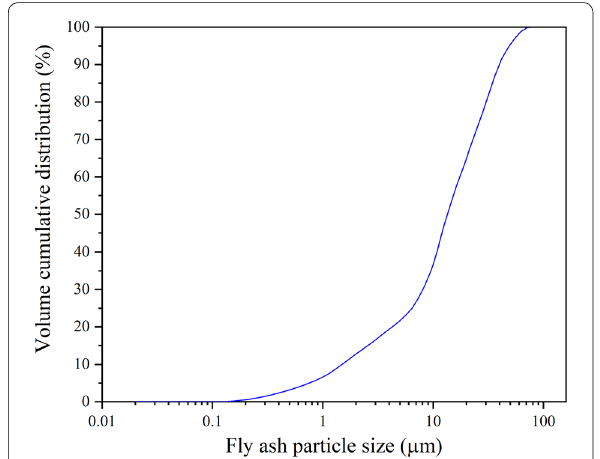
Fig. 2 The fly ash particle size